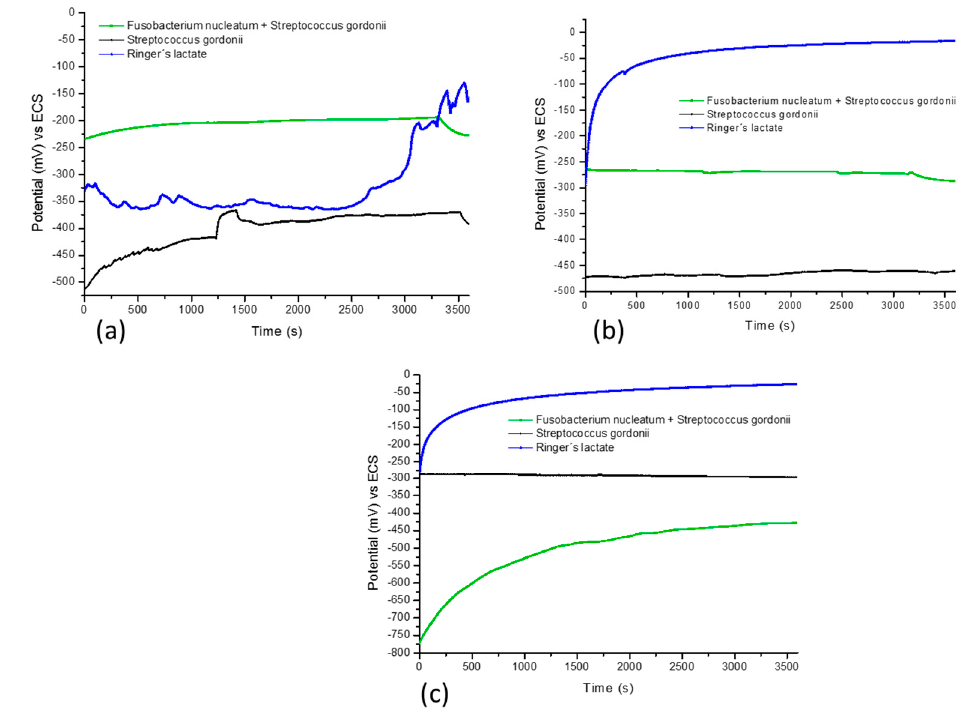
Figure 1. Open circuit potentials of titanium alloy (Ti6Al4V) at 0 ( a ), 48 ( b ), and 96 ( c ) hours of exposure in: Fusobacterium nucleatum + Streptococcus gordonii ; Streptococcus gordonii ; and Ringer’s lactate solution at 37 °C.